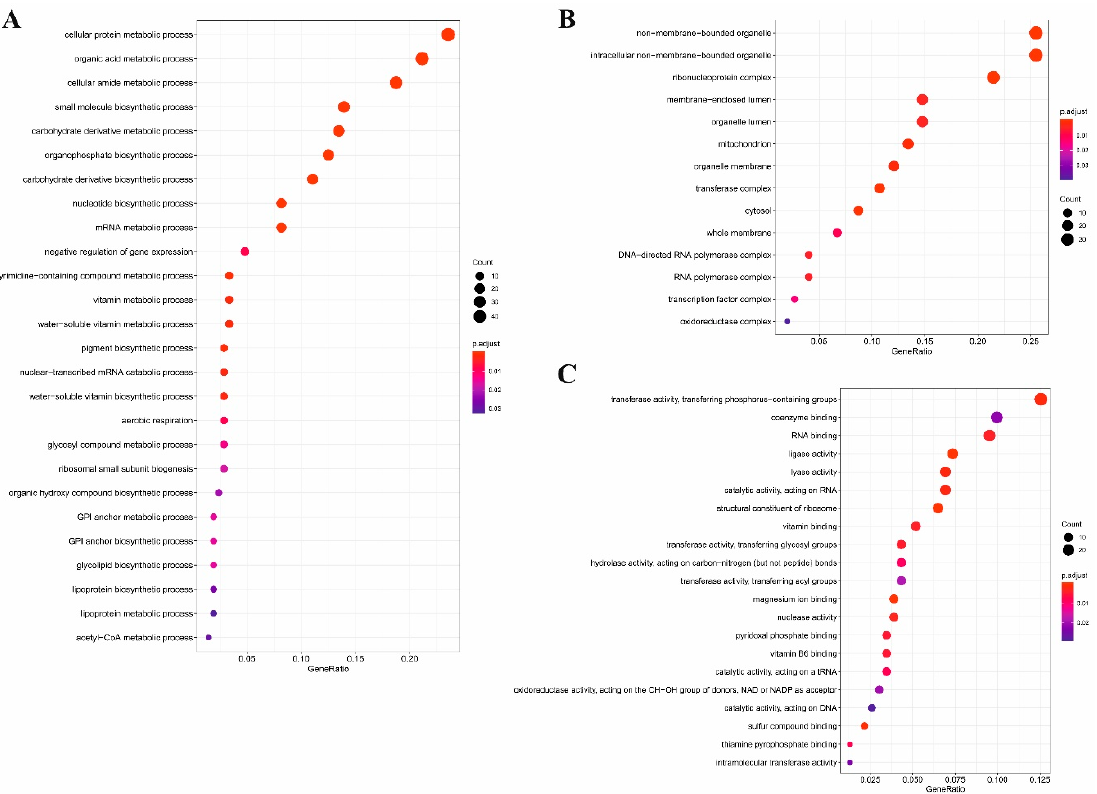
Figure 1. Results of a gene ontology (GO) gene set enrichment analysis (GSEA) of Penicillium rubens upregulated genes for di ff erent GO domains’ ( A ) biological processes, ( B ) cellular components and ( C ) molecular functions. The figures describe the rate of involvement of upregulated genes in the processes (black circles) and, also, about the significance (color changes from blue to red).